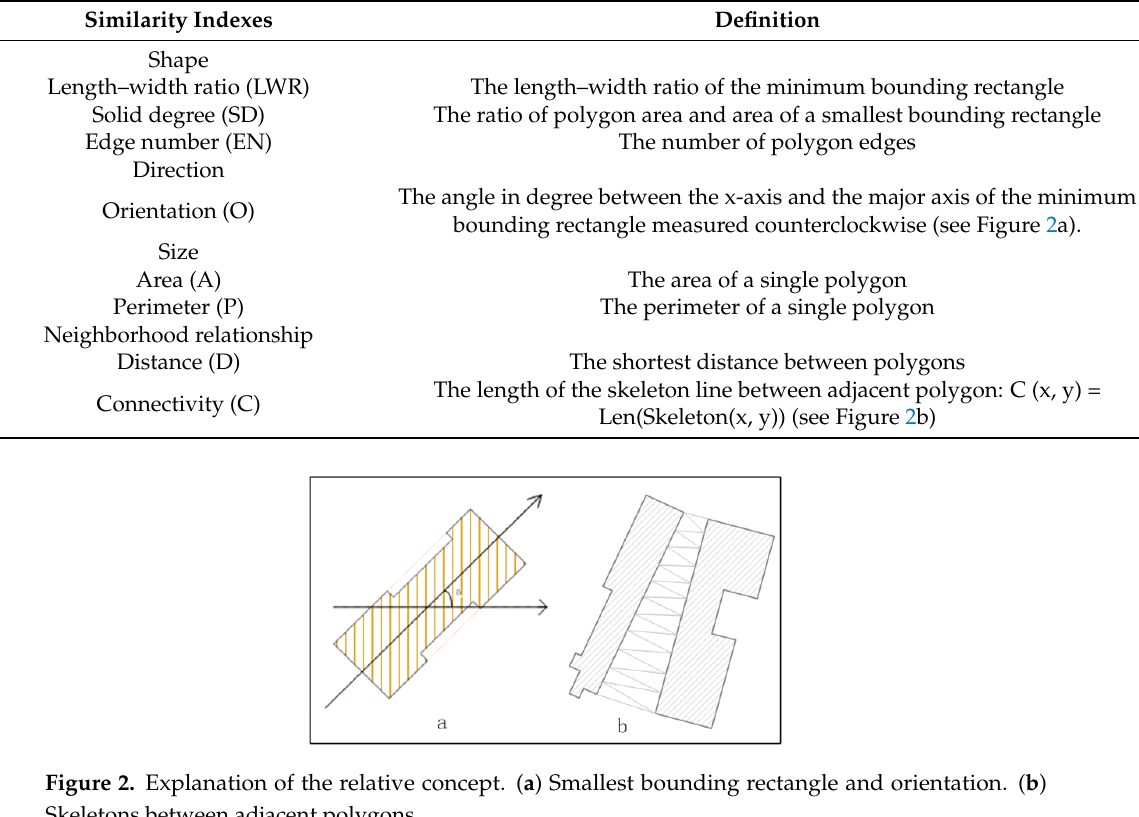
Table 1. Definition of polygon space spatial index.